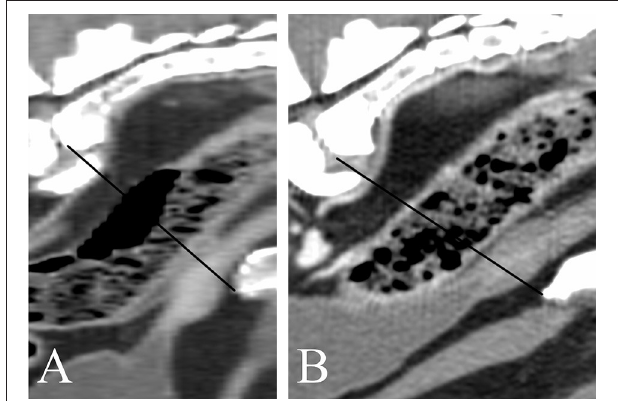
FIGURE 2 | Sagittal CT-reconstruction showing prostates in an abdominal (A) and pelvic location (B) , respectively. The black line indicates the pelvic